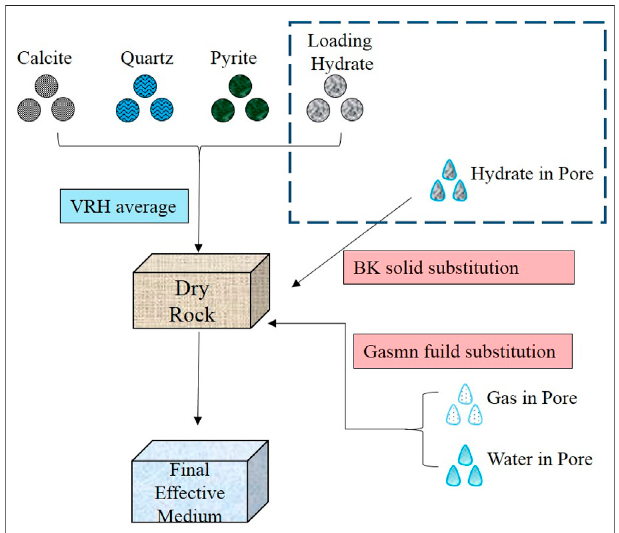
(9 ) FIGURE 9 | Flow chart of two-phase hydrate modeling.